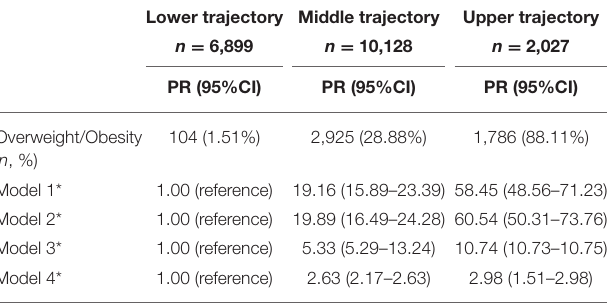
TABLE 3 | Results from log-binomial regression of the associations between childhood obesity/overweight and BMI